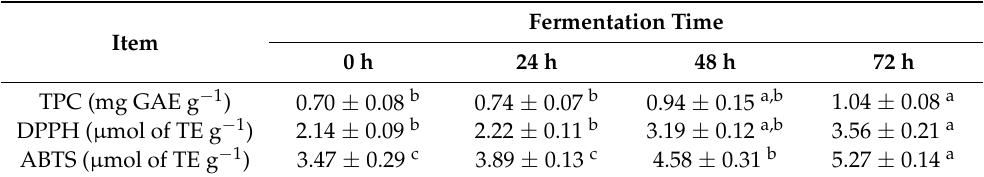
Table 2. Total phenolic content and potential antioxidant activities in fermented oat extract during fermentation up to 72 h (mean ± SE), n = 8.